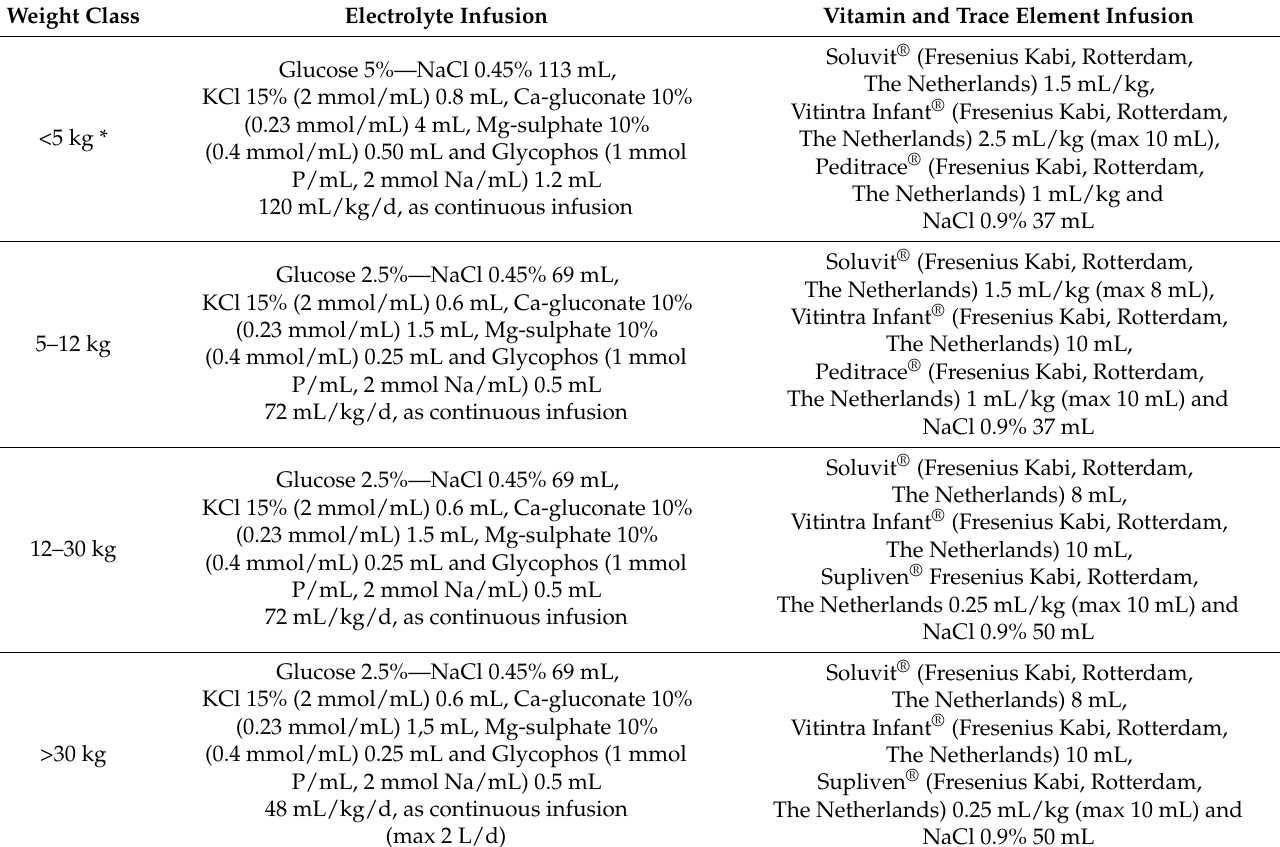
Table 3. The micronutrient provision in critically ill children (Ref.